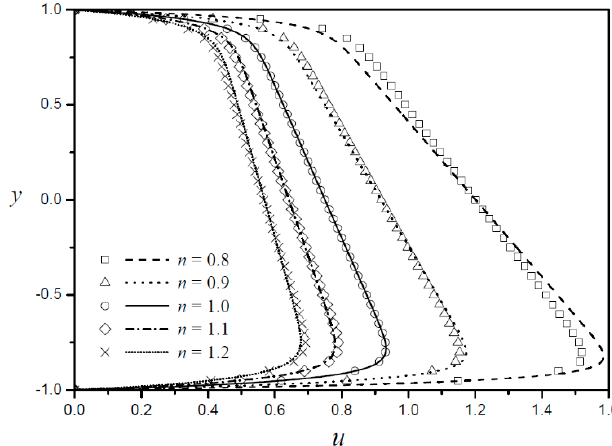
Figure 6. Velocity profiles according to the fluid behavior index with fixed zeta potential ratios ( (cid:1852) (cid:3019) =